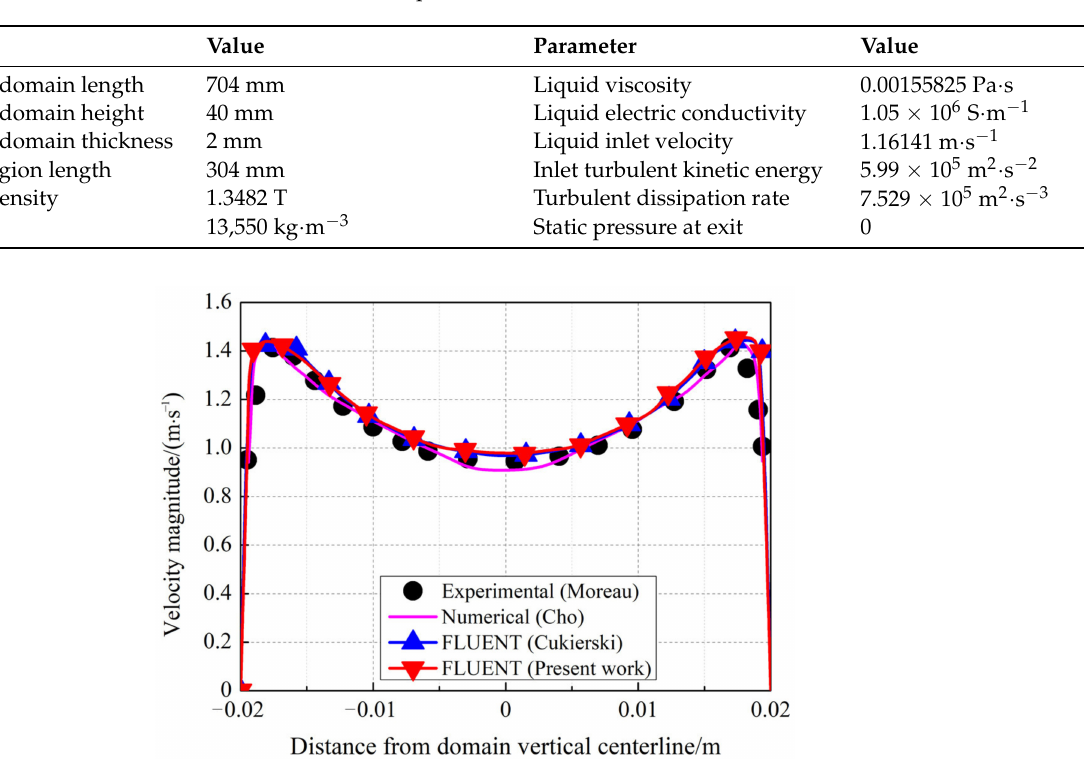
Table 2. Parameters of 3D plate used in numerical simulation.